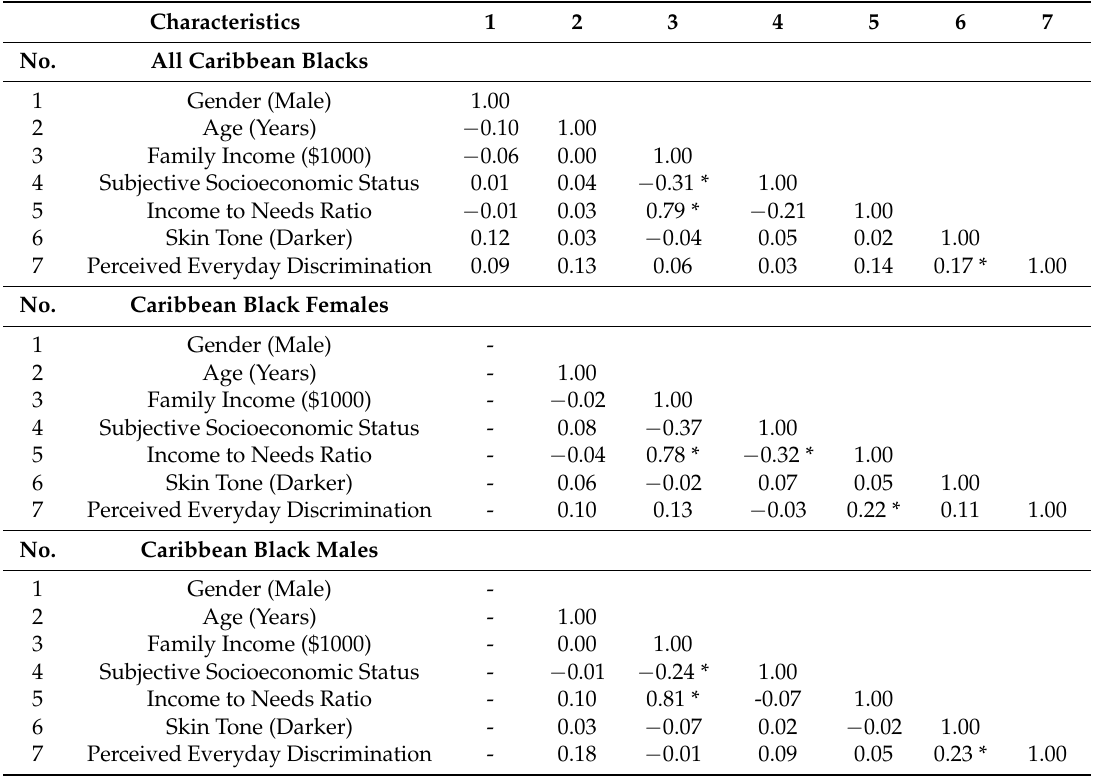
Table 2. Summary of correlation matrix in the pooled sample of Caribbean Black youth. Characteristics